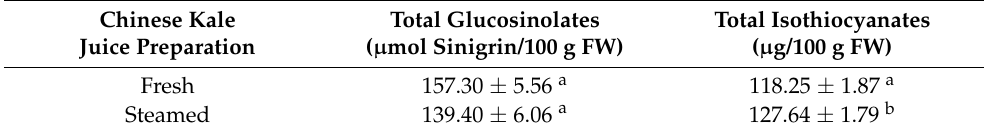
Table 1. Total glucosinolate and total isothiocyanate contents of Chinese kale